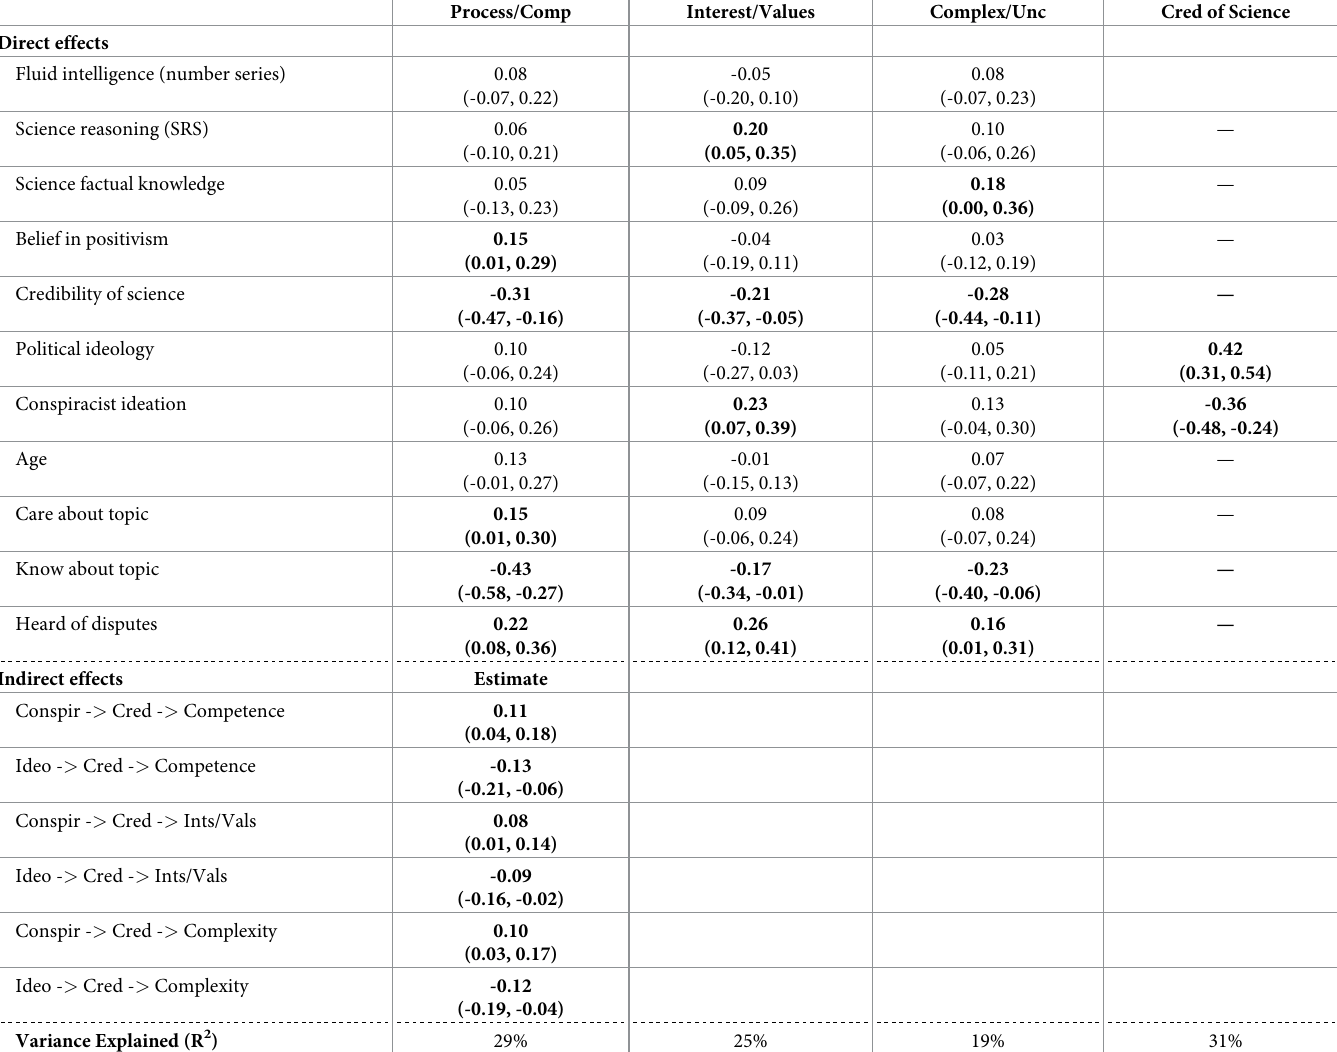
Table 5. Study 2. Direct/Indirect effects from SEM for participants who read the Nanotechnology scenario ( N =